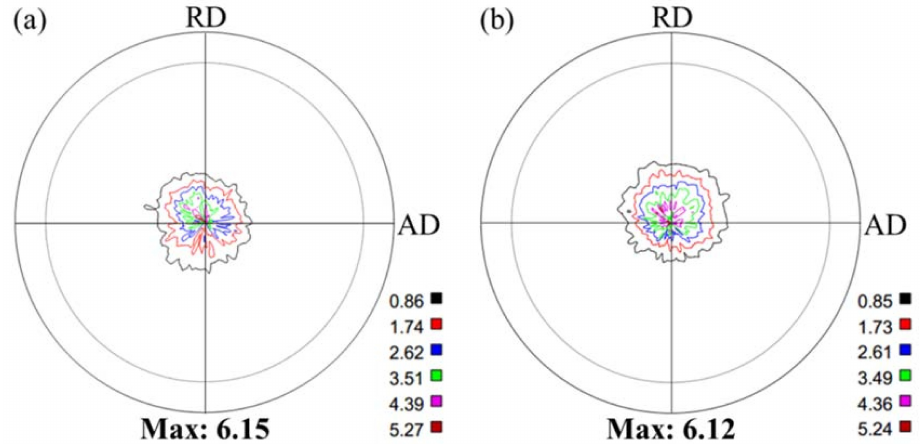
Figure 2. (0002) pole figures of ( a ) HRRed and ( b ) T5